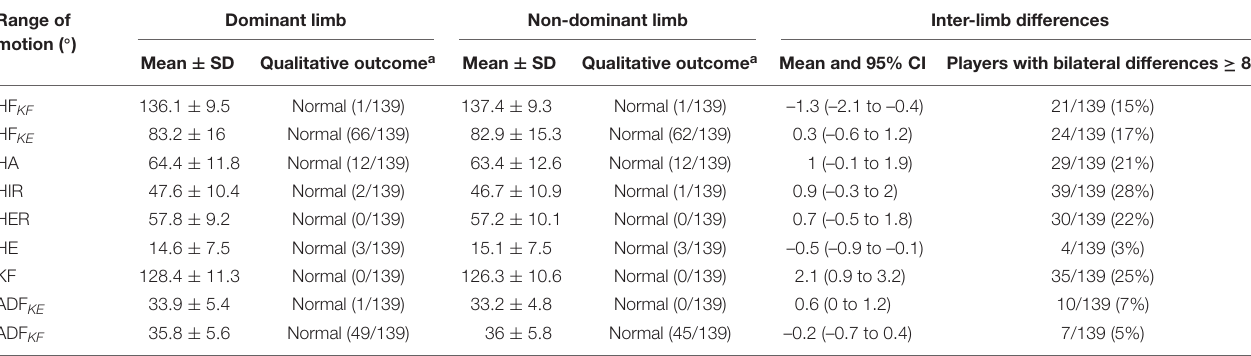
TABLE 2 | Descriptive values and inter-limb differences for hip (flexion, extension, abduction, internal, and external rotation), knee (flexion), and ankle (dorsalflexion with knee flexed and extended) ranges of motion for all futsal players combined ( n = 139). Range of motion ( ◦